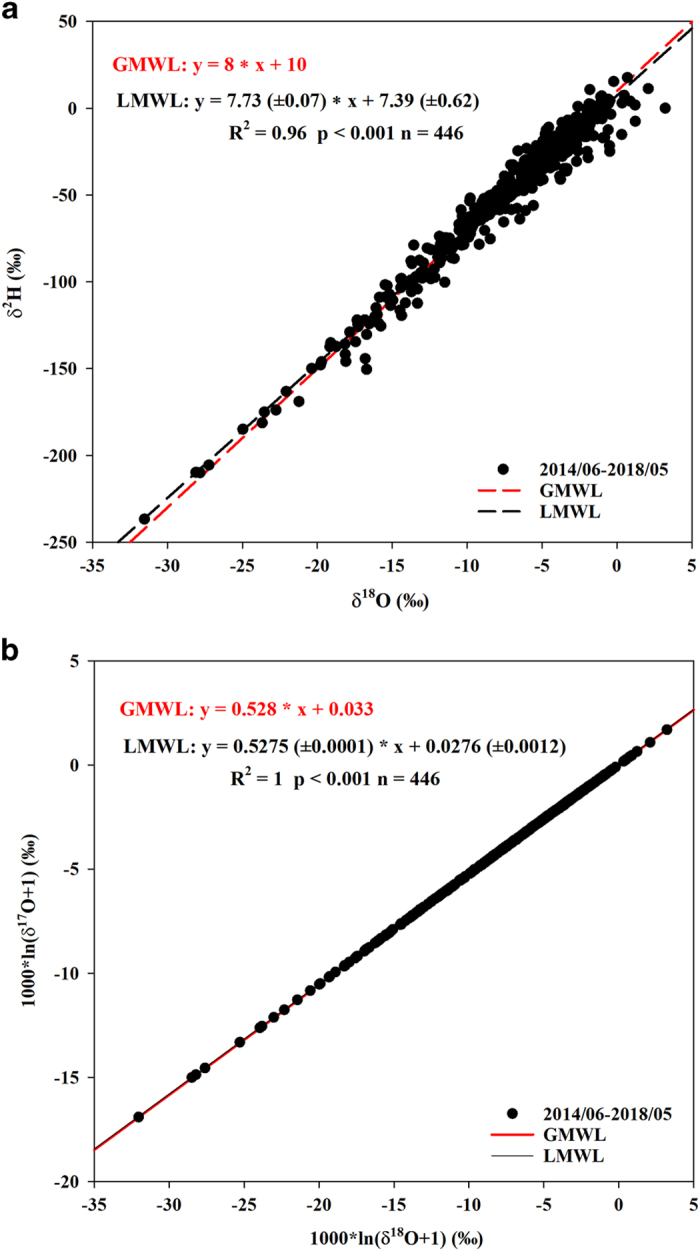
The relationships between precipitation δ18O and δ2H as well as between δ18O and δ17O during June 2014 and May 2018 in Indianapolis, Indiana, U.S.(a) the relationship between δ18O and δ2H; (b) the relationship between δ18O and δ17O.